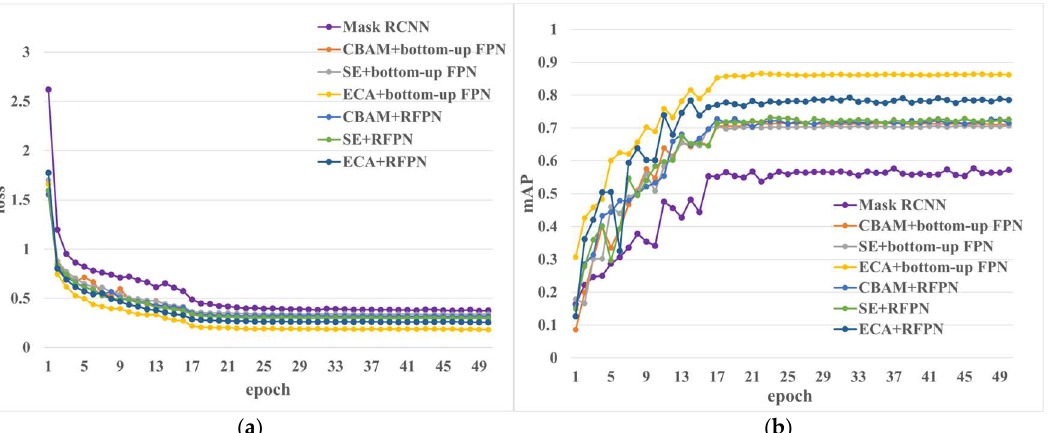
Figure 13. Loss and mAP of the models with different AM and FPN modules. ( a ) Loss of the model with fusing AM and FPN. ( b ) mAP of the model with fusing AM and FPN.